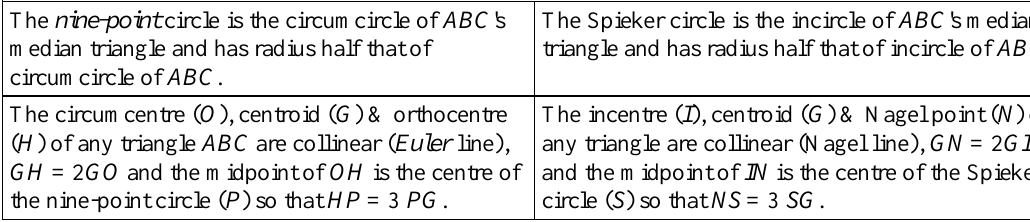
Table 1: Analogy between the Euler and Nagel lines of a triangle The nine-point circle is the circumcircle of ABC 's median triangle and has radius half that of circumcircle of ABC .